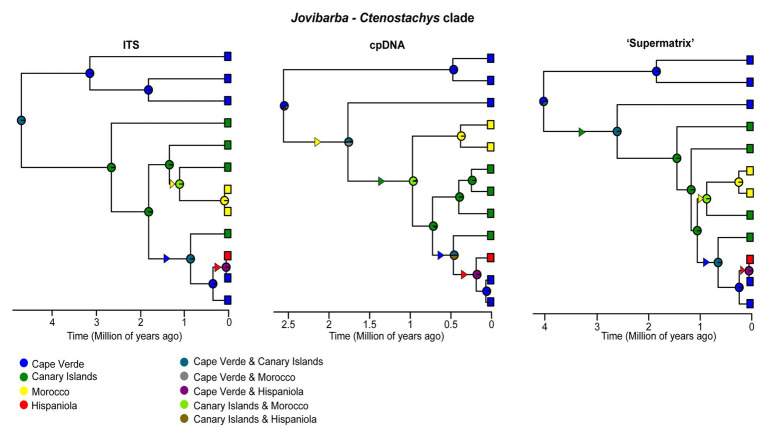
Ancestral range estimates for the Jovibarba – Ctenostachys clade of Limonium cropped from the ITS, cpDNA and “Supermatrix” MCC trees. The four areas used for biogeographic analyses and their combined ranges are color coded as in the left and right column, respectively, of the inset at the bottom. Pie charts on the nodes of trees represent relative probabilities of the inferred ancestral ranges. Triangles along branches indicate range expansions and their colors indicate the colonized area.